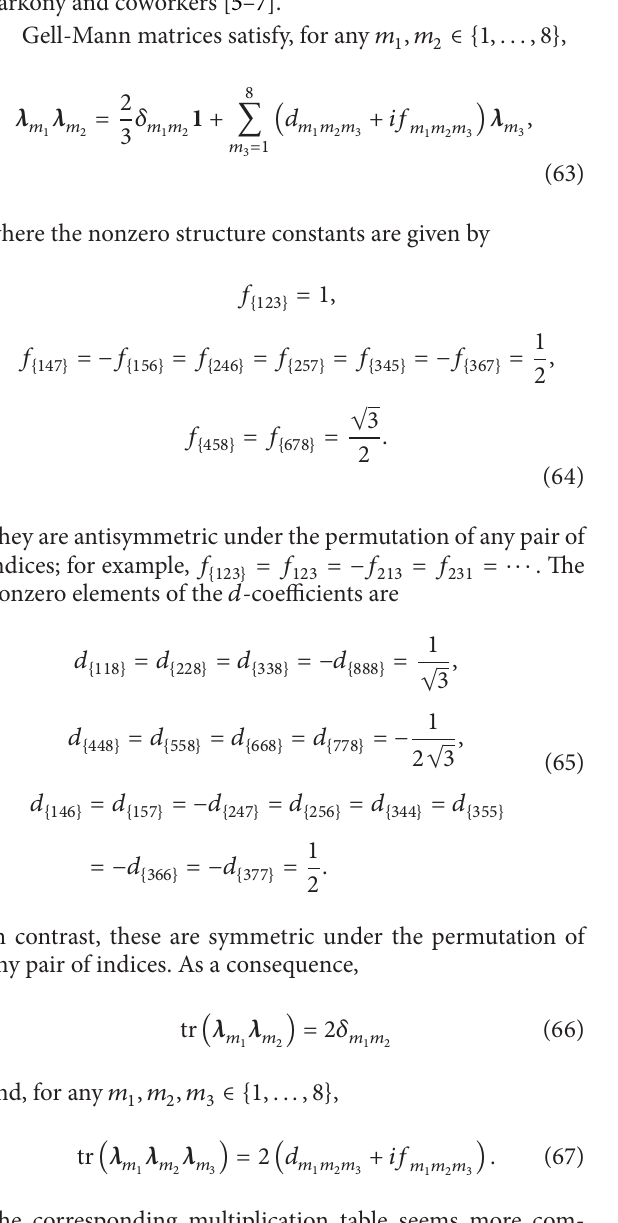
Table 2: Multiplication table of Gell-Mann matrices { 𝜆 1 , 𝜆 2 , 𝜆 3 , 𝜆 8 } (left times top).